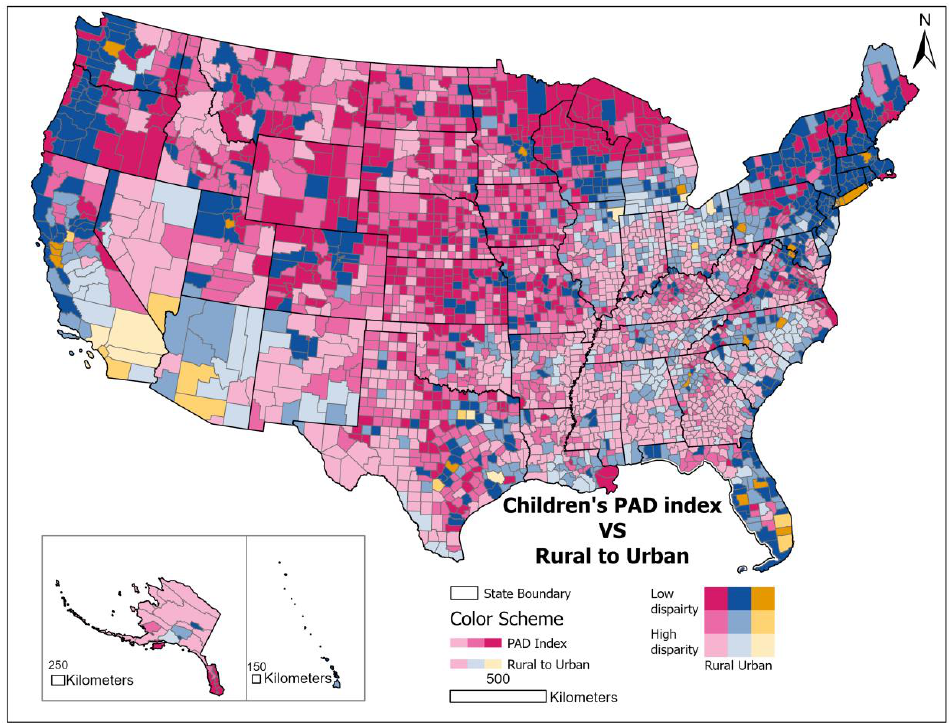
Figure 3. Children’s PAD index vs. Rural to Urban classification in a bivariate choropleth map.